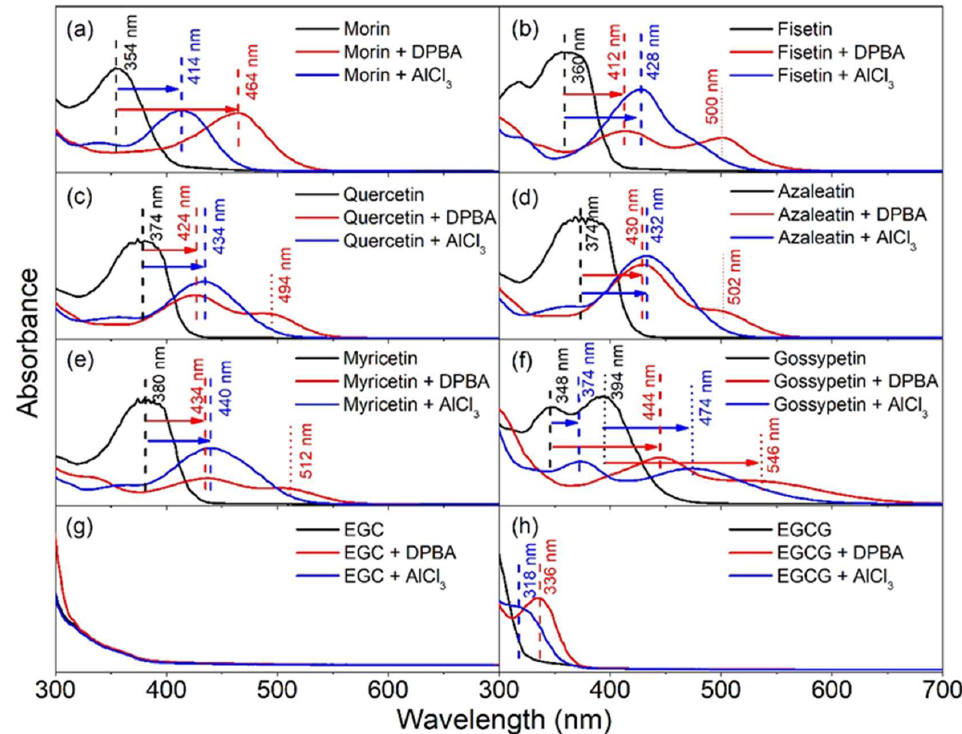
Figure 2. UV-visible spectra of flavonoids showing absorption bands and their shifts after they were treated with DPBA and AlCl 3 . Impact of DPBA and AlCl 3 into the band shift of ( a ) morin, ( b ) fisetin, ( c ) quercetin, ( d ) azaleatin, ( e ) myricetin, ( f ) gossypetin, ( g ) epigallocatechin (EGC) and ( h ) epigallocatechin gallate (EGCG). The absorption spectra of DPBA and AlCl 3 in DMSO in absence of flavonoids are provided in the Supplementary Materials in Figure S2. Dashed and dotted lines represent the positions of absorption peaks before and after their shifts, respectively. Table 1. Bathochromic shifts of absorption peaks of the flavonoids induced by AlCl 3 and DPBA. Peak Positions (nm) Flavonoids Peak Position (nm)